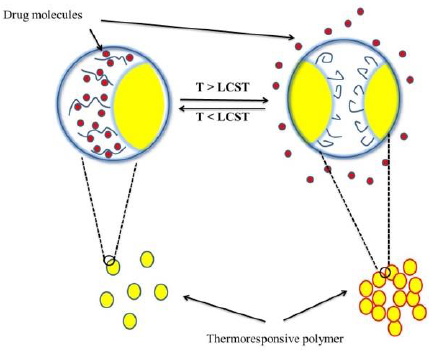
Figure 4. Schematic illustration of the LCST-type phase transition.